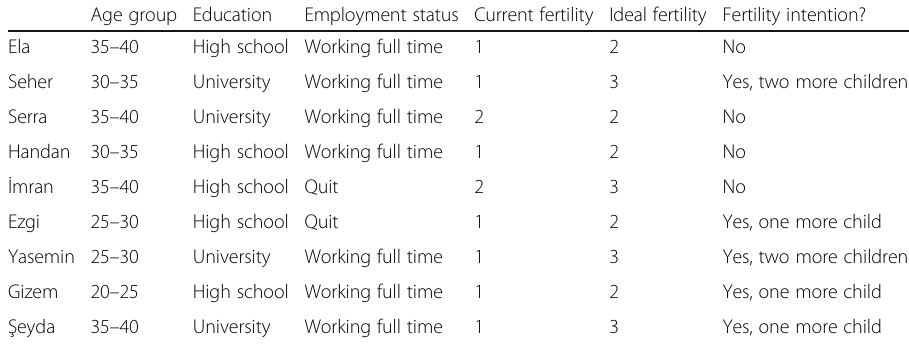
Table 2 Respondents ’ demographic characteristics, ideal fertility, and fertility intention Age group